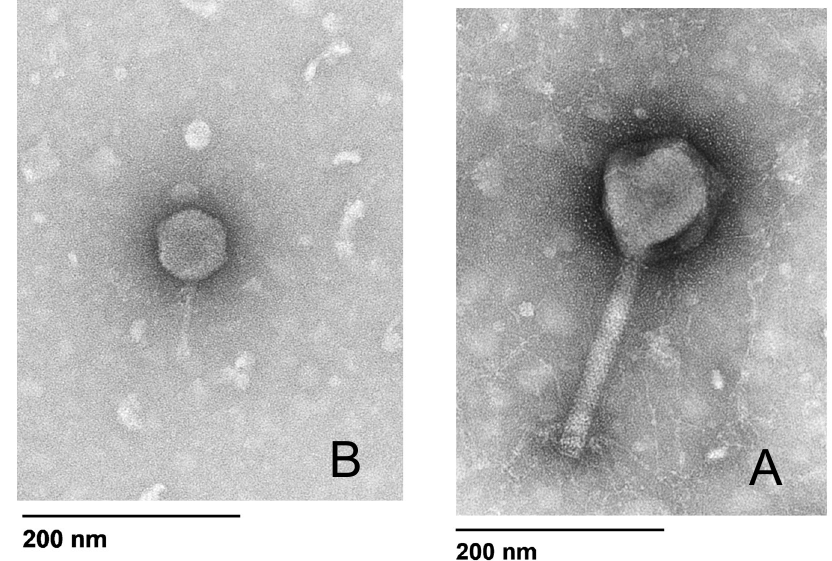
Figure 6. Transmission electron micrographs. Transmission electron micrograph of ( A ) PA4 belong- ing to Myoviridae family and ( B ) PA8 belonging to Podoviridae family.